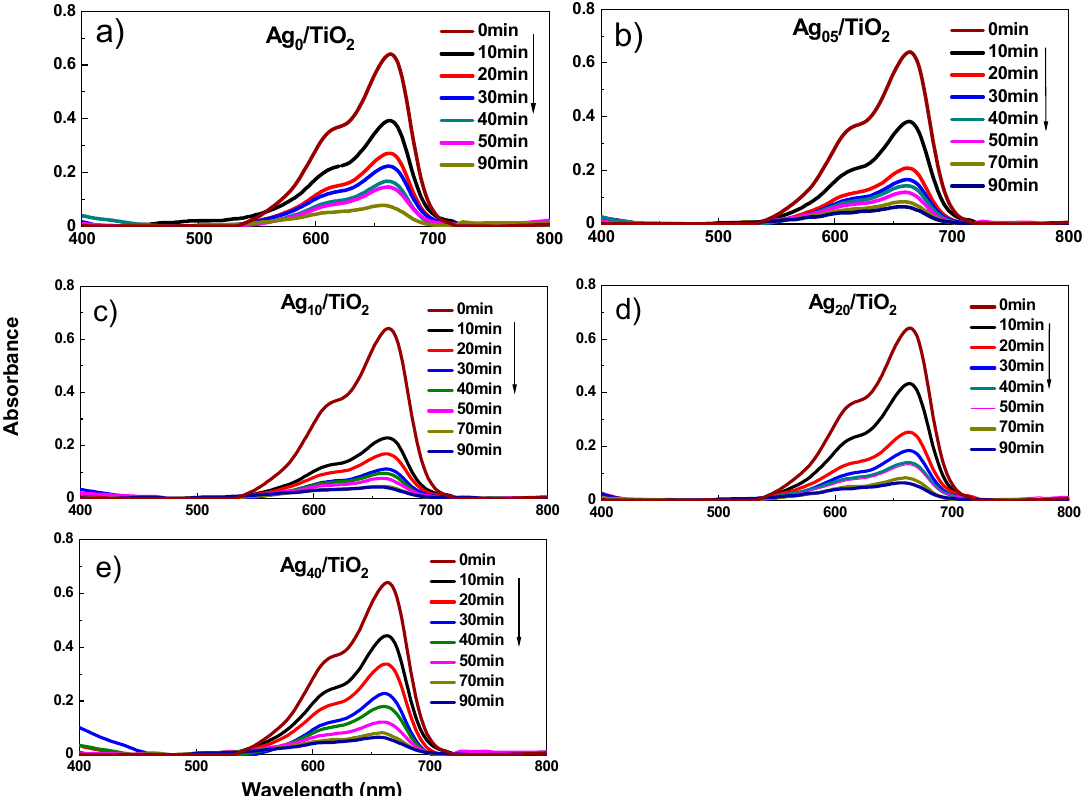
Figure 7. The degradation of methylene blue due to the irradiation in the presence of Ag x / TiO 2 nanostructures; ( a ) Ag 0 / TiO 2 , ( b ) Ag 5 / TiO 2 , ( c ) Ag 10 / TiO 2 , ( d ) Ag 20 / TiO 2 , ( e ) Ag 40 / TiO 2 .